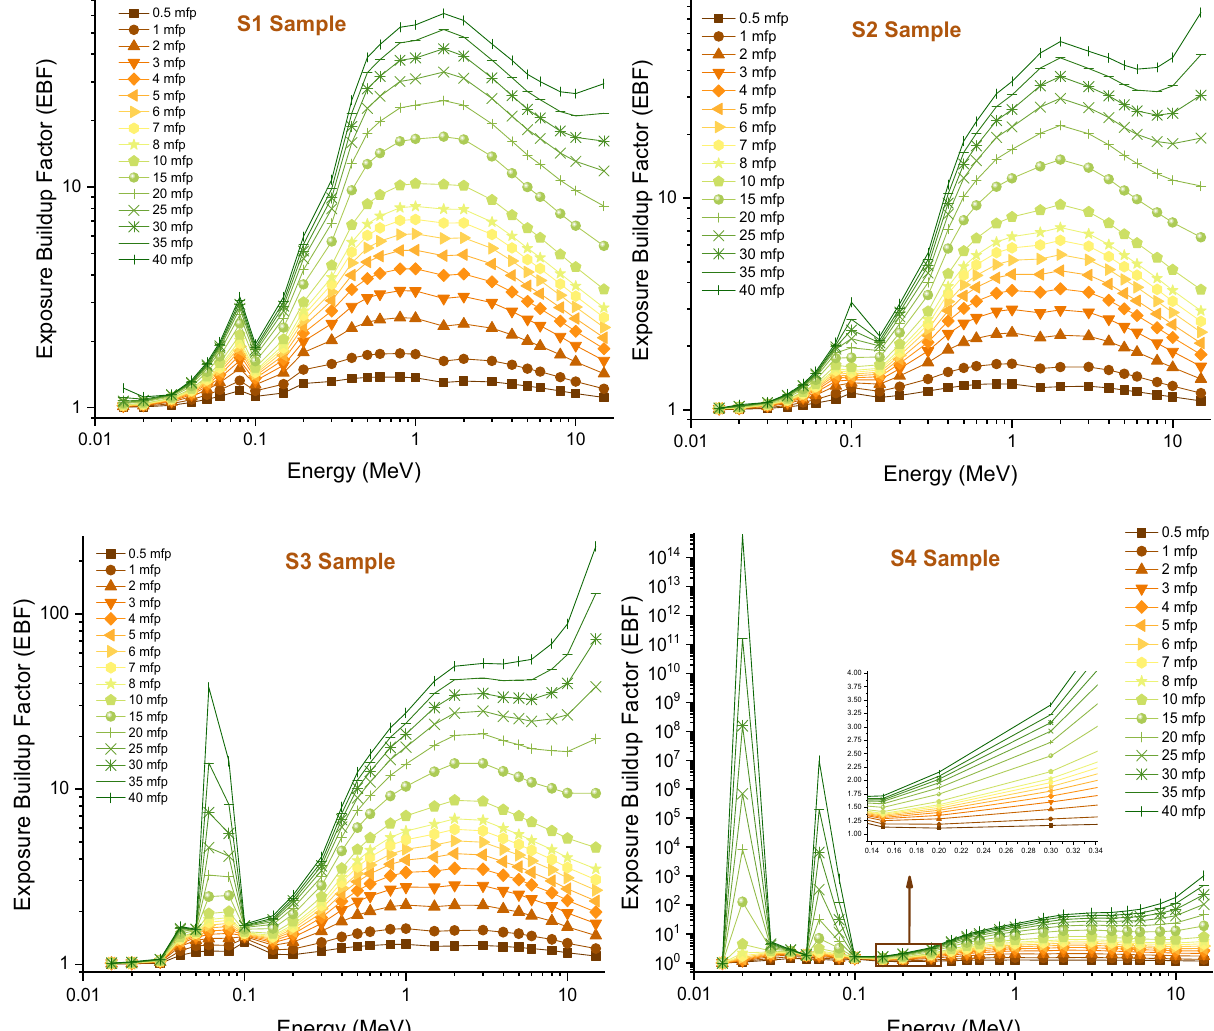
Figure 13: Variation of EBFs of investigated glasses at di ff erent mfp